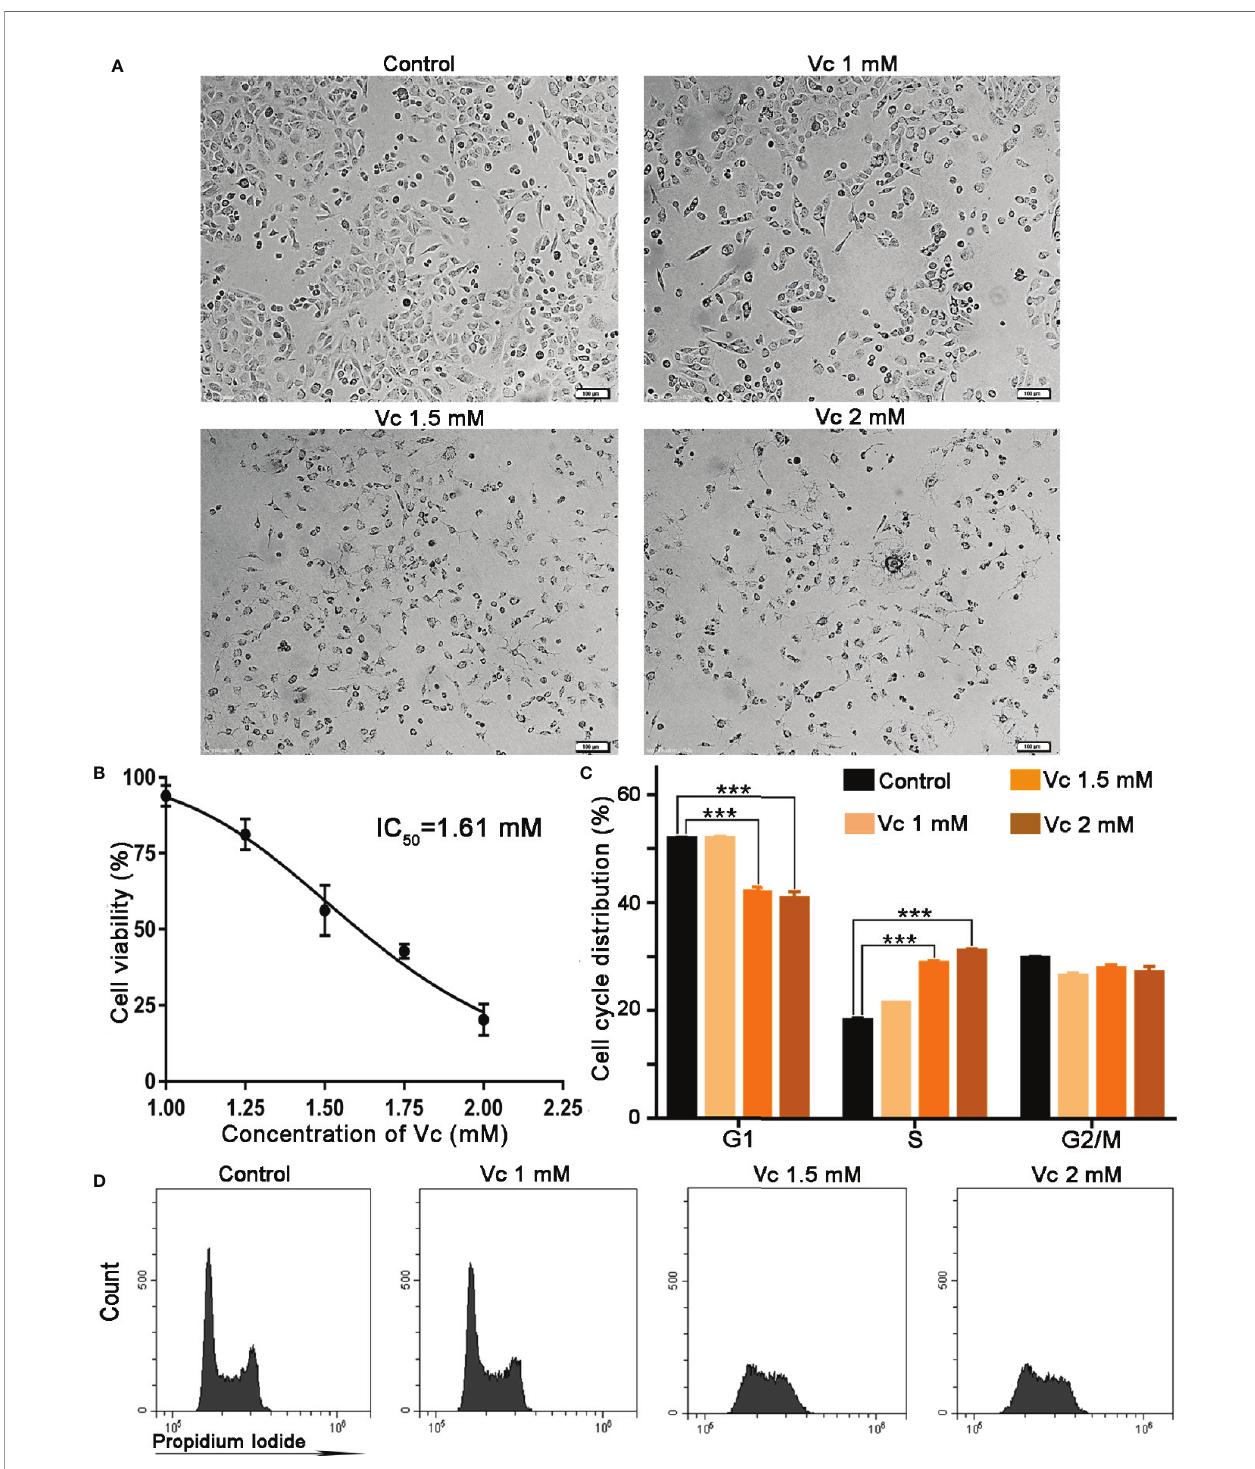
FIGURE 6 | Vitamin C inhibits proliferation and induces cell cycle arrest at S stage in ID8 cells. (A) Representative photographs of ID8 cells in different groups. ×100. (B) Cytotoxicity of pharmacologic vitamin C on ID8 ovarian cancer cells. Data are mean ± SEM; n=3. (C) The statistical data of cell cycle distribution. Data are mean ± SEM; n=4. ***p < 0.001. (D) A fl uorescence pattern of Propidium Iodide (PI) stained